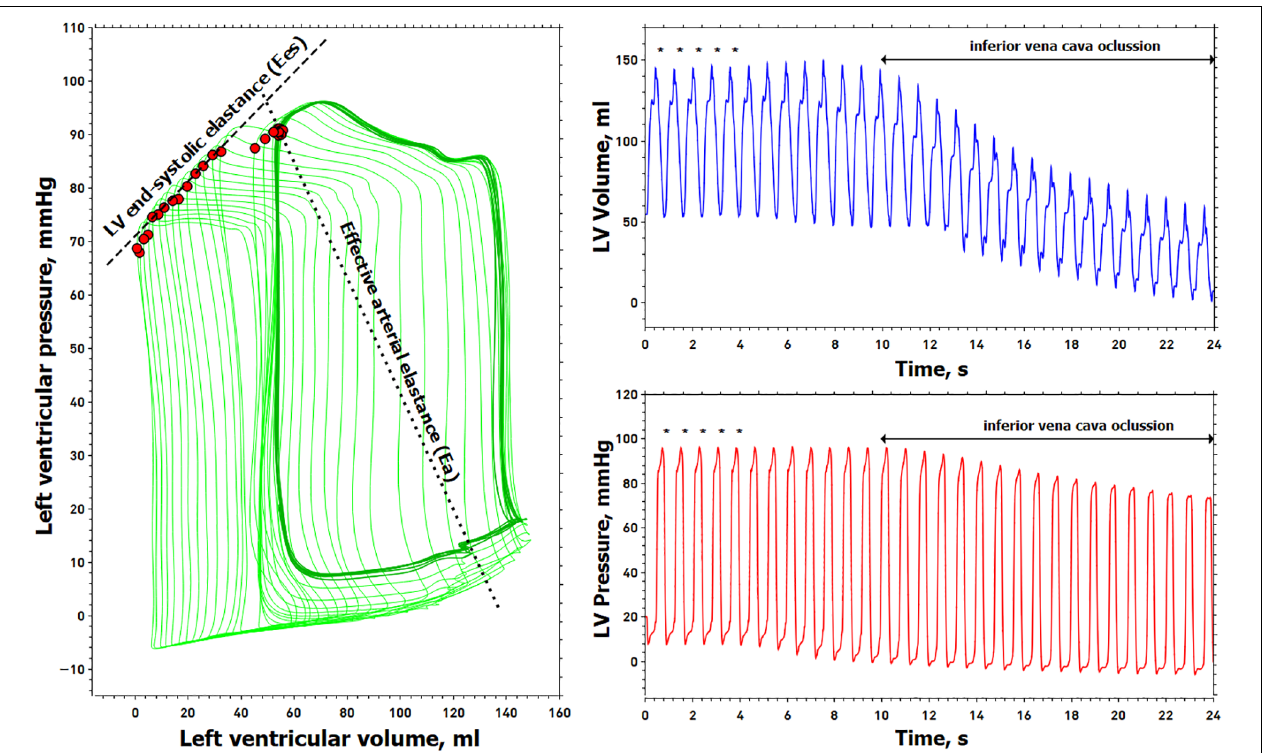
FIGURE 1 | Example of the left ventricular pressure-volume analysis. Left, left ventricular (LV) pressure-volume loops (green line). Right, simultaneous recording of LV volume (blue line) and pressure (red line), from which LV pressure-volume loops were constructed. Red points in the PV loop are the maximal elastance for each cardiac cycle. The slope of these maximum elastance values is obtained during a transient decrease in preload represents the LV end-systolic elastance (Ees). The outlined pressure-volume loops (dark green line) represent five cardiac cycles obtained just before the inferior vena cava (IVC) occlusion (marked with an asterisk above the pressure-volume waveforms) for determining end-systolic pressure, stroke volume, end-diastolic volume, end-systolic volume, and effective arterial elastance (Ea). The dashed line connects the maximal elastance during the IVC maneuver and represents the end-systolic elastance (Ees). The dotted line connects the end-systolic pressure with the end-diastolic volume representing the effective arterial elastance